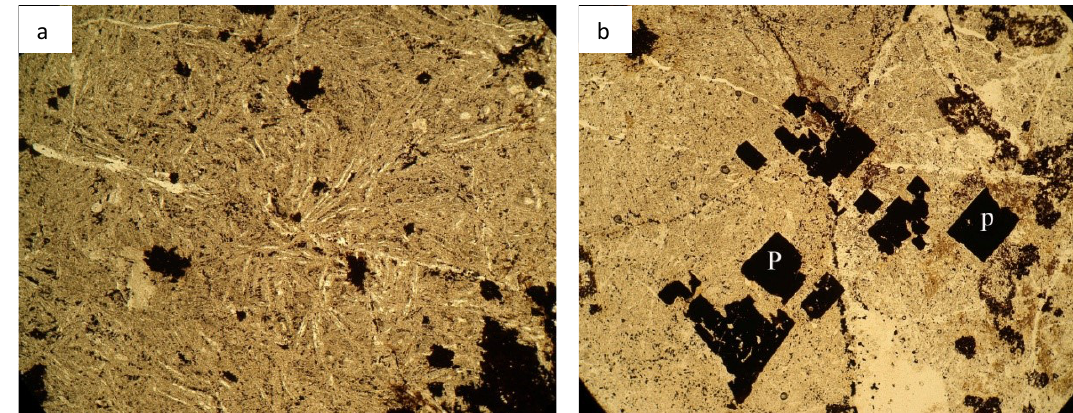
Figure 3 . The growth of beam shaped sericite aggregate in the Burgetei, Sample BG- 2/16 (а) and sample BG-4/16 (b). P – Pyrite crystals